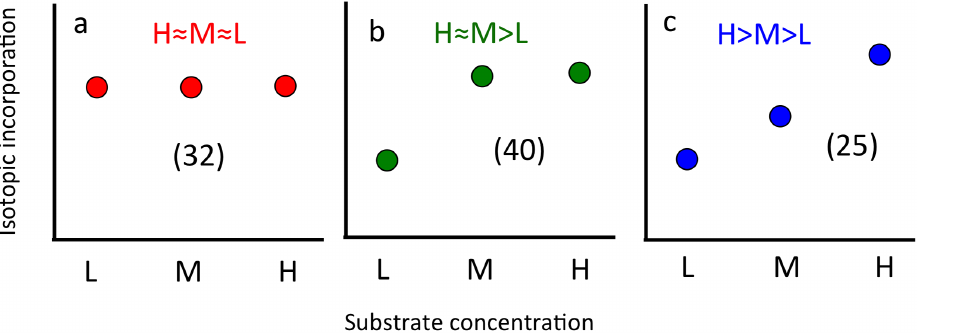
Figure 3. Three different types of microbial responses to resource availability identified by measuring isotopic incorporation of amino acids at High, Medium, and Low concentrations in SF Bay, with the numbers of taxa identified in parentheses.